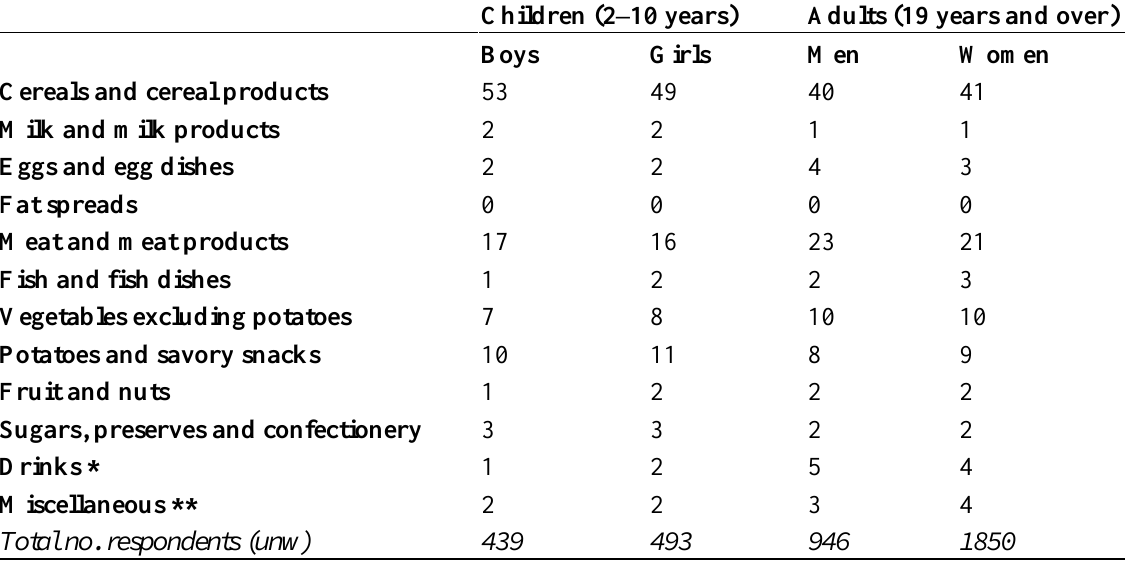
Table 8 . The Low Income Diet and Nutrition Survey (LIDNS)—Contribution (%) of food types to average daily intake of total